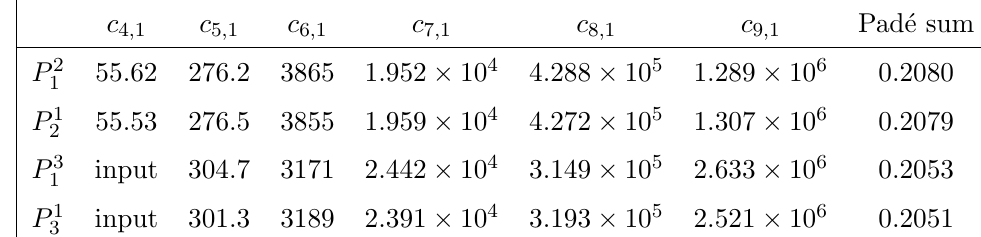
Table 4. QCD Adler function coe(cid:14)cients from PAs constructed to the (cid:11) s expansion of (cid:14) (0)